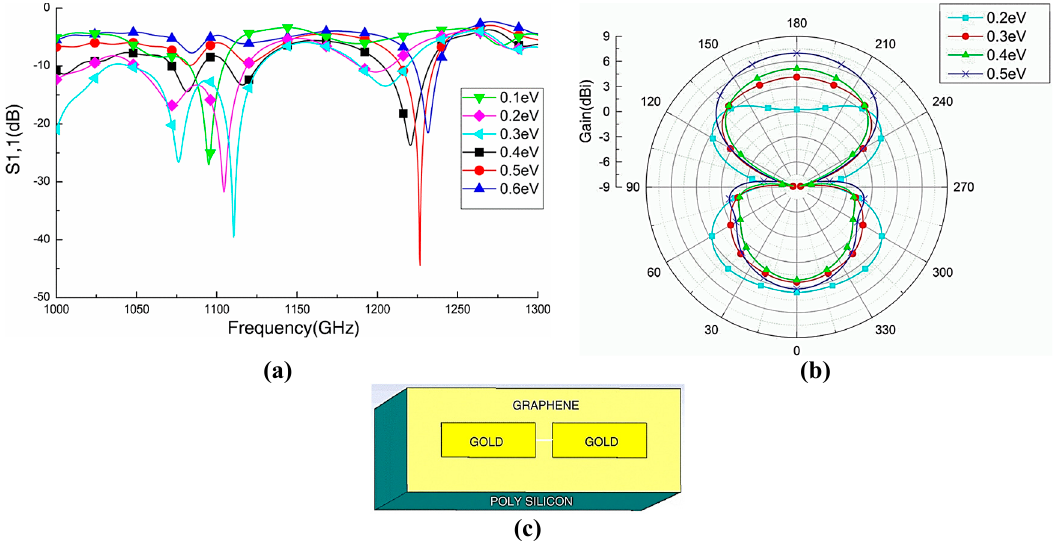
Figure 6. ( a ) Schematic of the graphene–metal hybrid antenna, where the graphene layer is inserted between quartz substrate and gold patches; ( b ) reflection coefficient hybrid antenna with respect to chemical potential; and ( c ) gain polar plots and changes in bandwidth by increasing the chemical potential. © 2016 IEEE. Reprinted from [110].